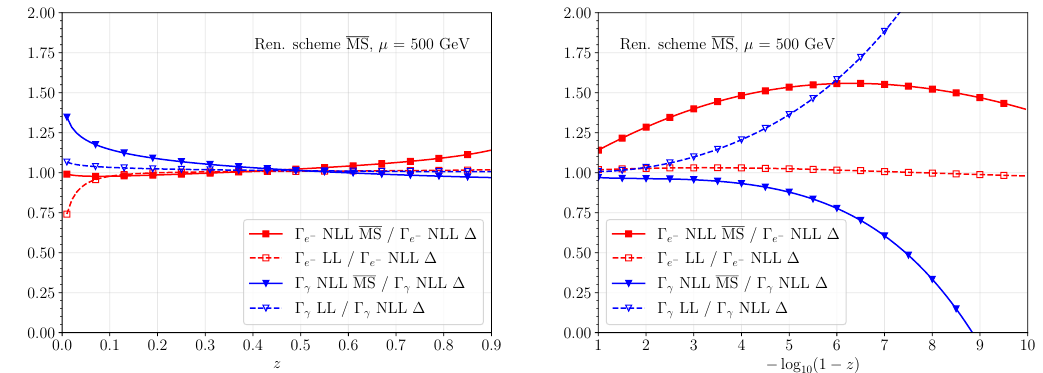
Figure 4 . Ratios of NLL MS PDFs (solid curves) and LL PDFs (dashed curves) over NLL ∆ PDFs, for an electron (red curves overlaid with boxes) and a photon (blue curves overlaid with triangles); all of the PDFs are computed in the MS renormalisation scheme. The ratios are shown for small- and intermediate- z (left panel), and for z ’ 1 (right